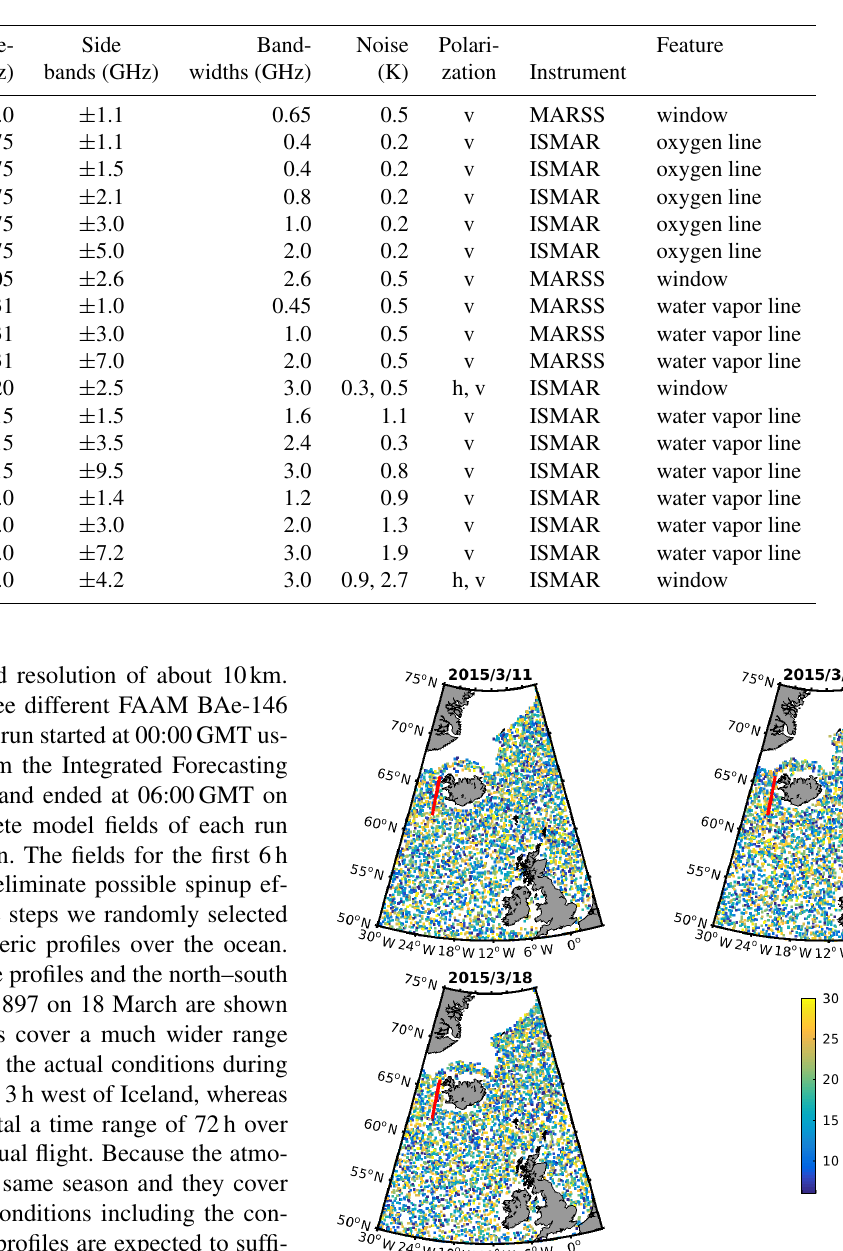
Table 1. Channel descriptions, taken mostly from Fox et al. (2017).